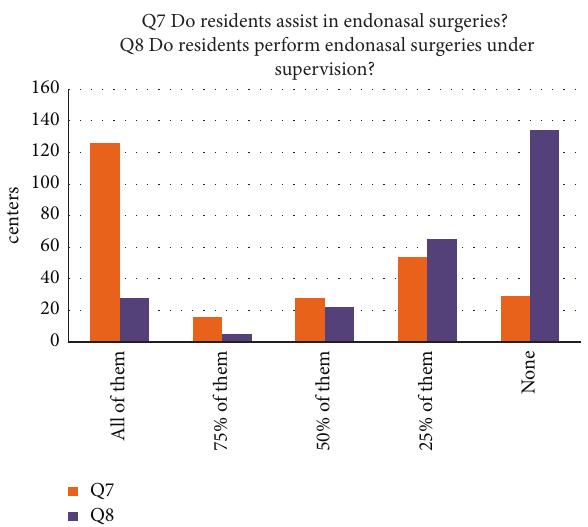
Figure 2: Residents’ exposure to endonasal surgeries.